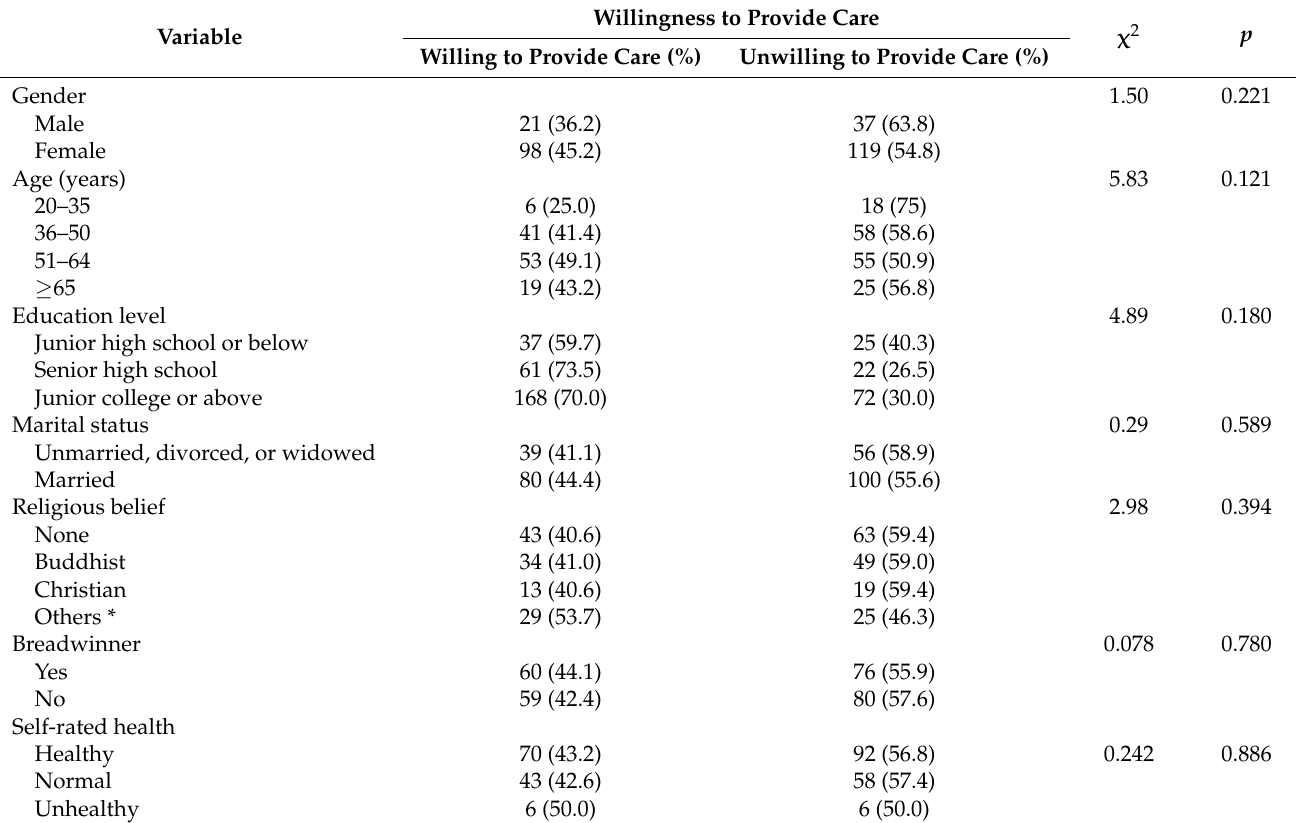
Table 2. Univariate analysis of demographic variables and willingness to provide care to patients with COVID-19 ( n =